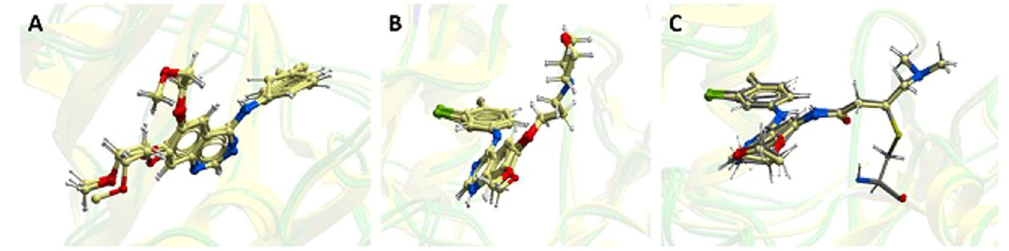
Figure 3. The results of the aligned TKIs. ( A ) Gefitinib. 2ITY was the template. ( B ) Erlotinib. 1M17 was the template. ( C ) Afatinib. 4G5J was the template. Each figure contained four TKIs. Three of them were for the EGFR mutant-TKI complexes and the other one was for the template.